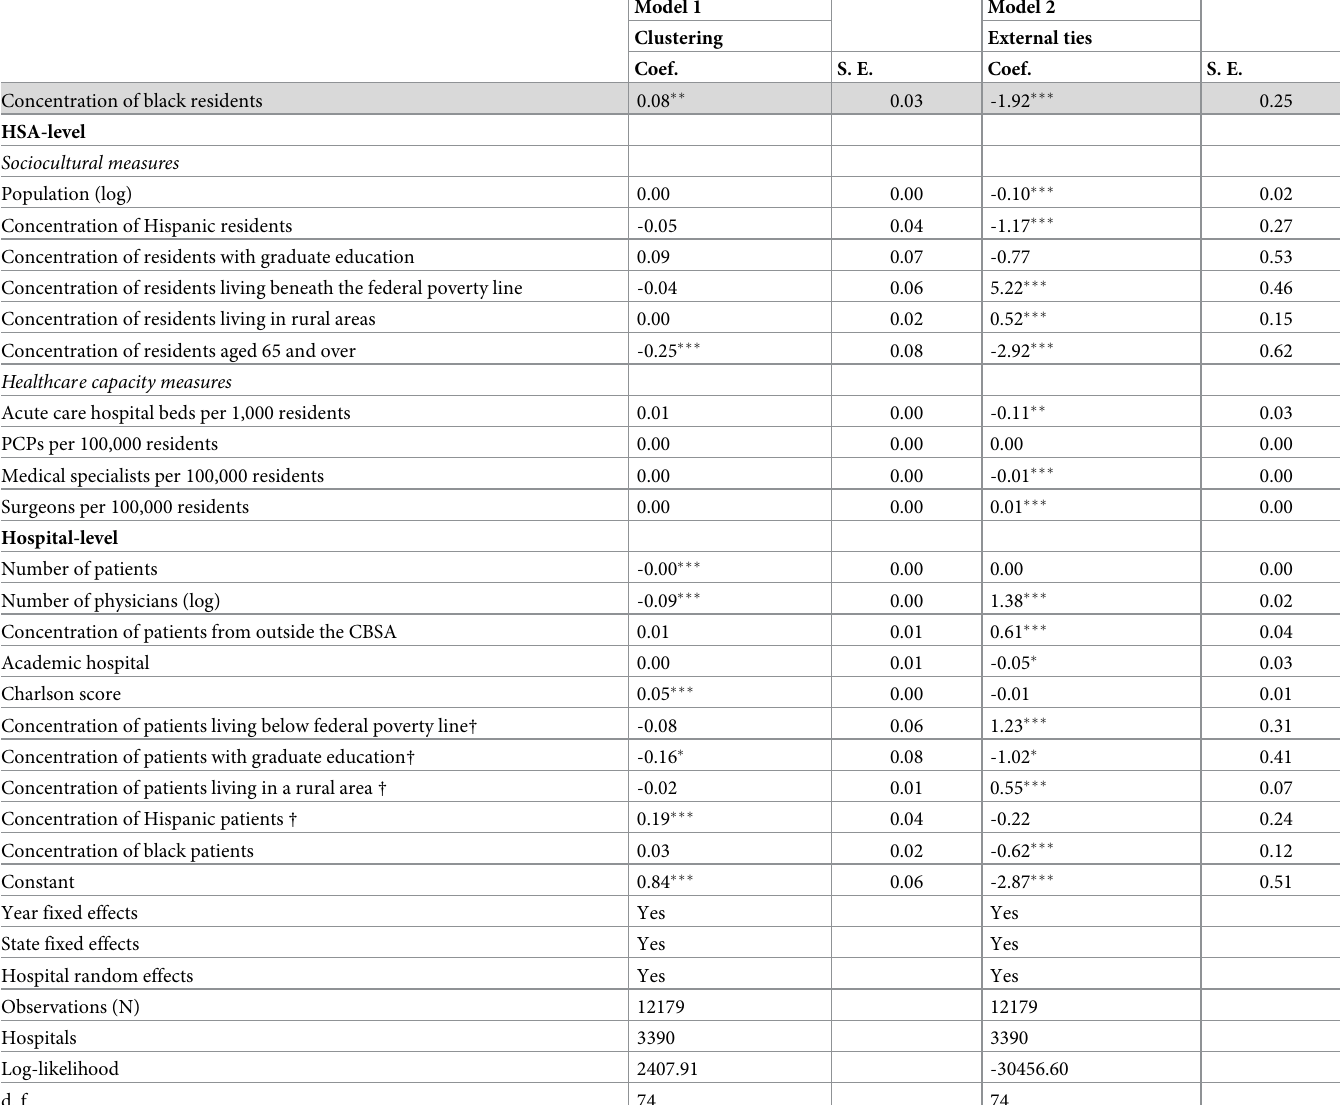
Table 2. Multivariate models of physician networks and concentration of black residents in U. S.